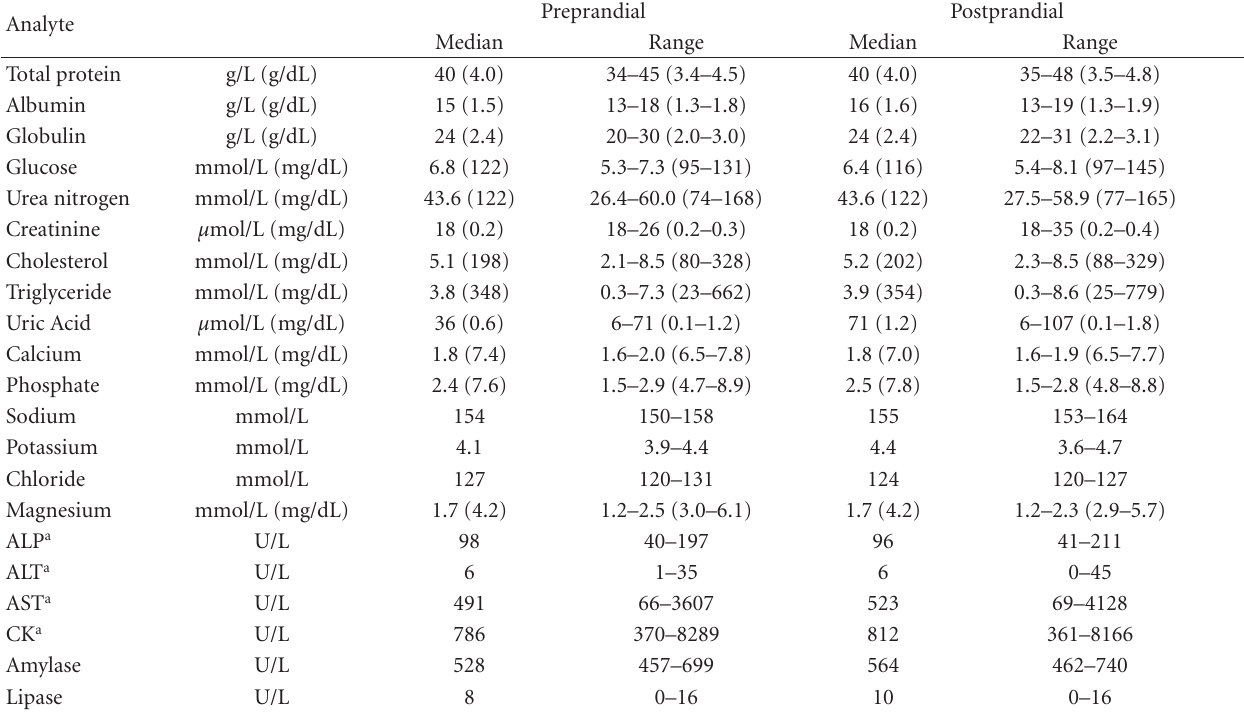
Table 2: Medians and ranges for preprandial and postprandial plasma biochemical values from juvenile Kemp’s ridley sea turtles ( n = 10). System International and conventional units (in parentheses) are